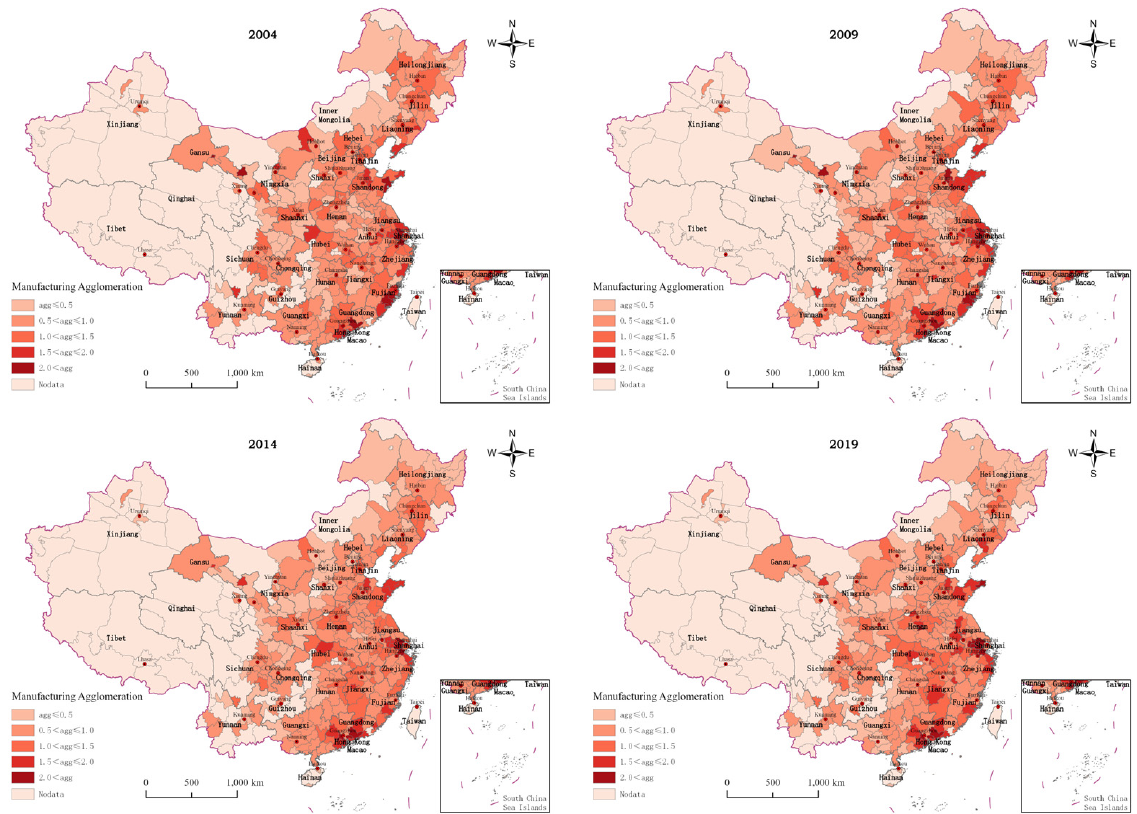
Figure 2. Spatial distribution of MA in Chinese Cities from 2004–2019.